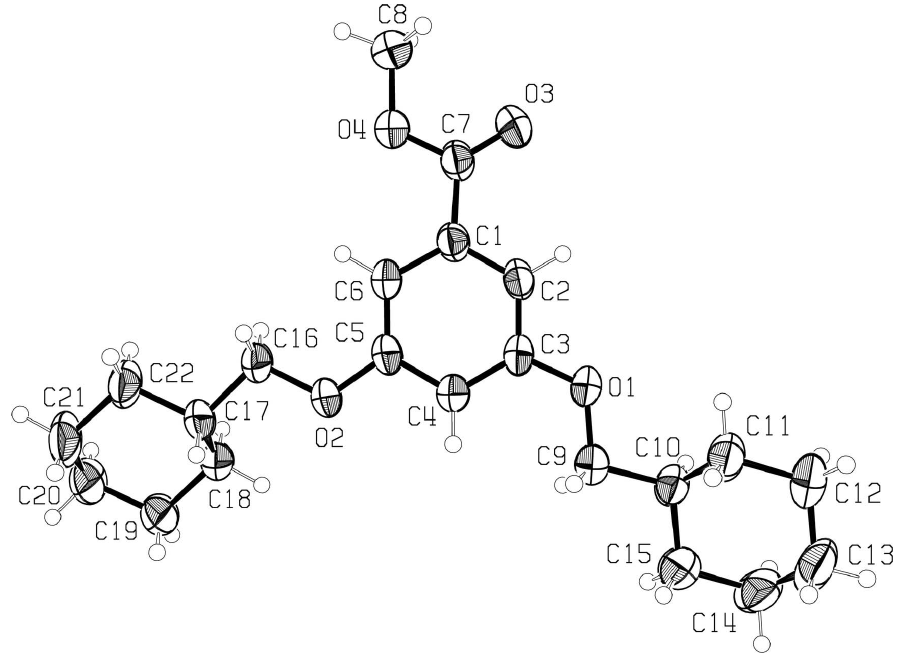
Figure 1 The molecular structure of the title molecule, with ellipsoids at the 50%